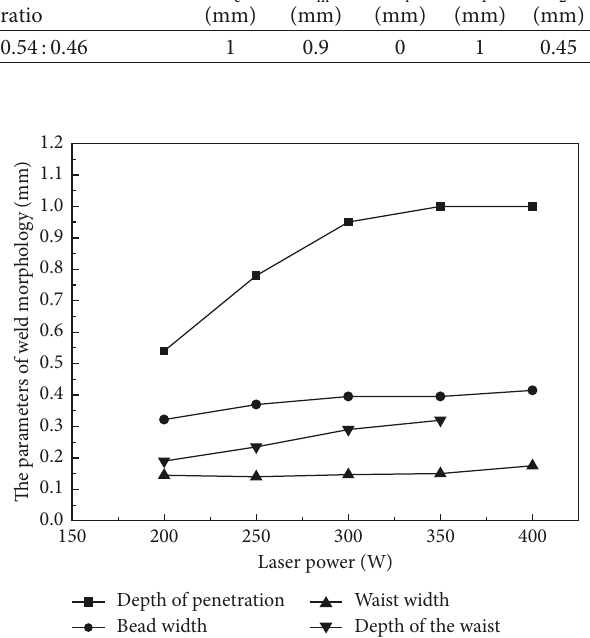
Figure 7: Effect of laser power on the depth of penetration, bead width, waist width, and depth of the waist for the butt joint.